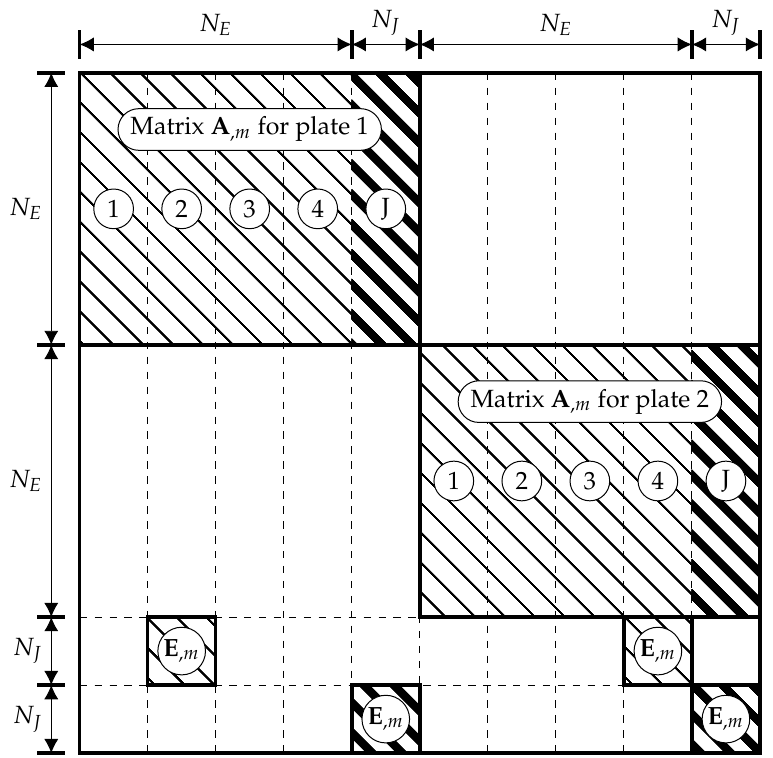
Figure 5. The A , m matrix for the assembled plate structure in Figure